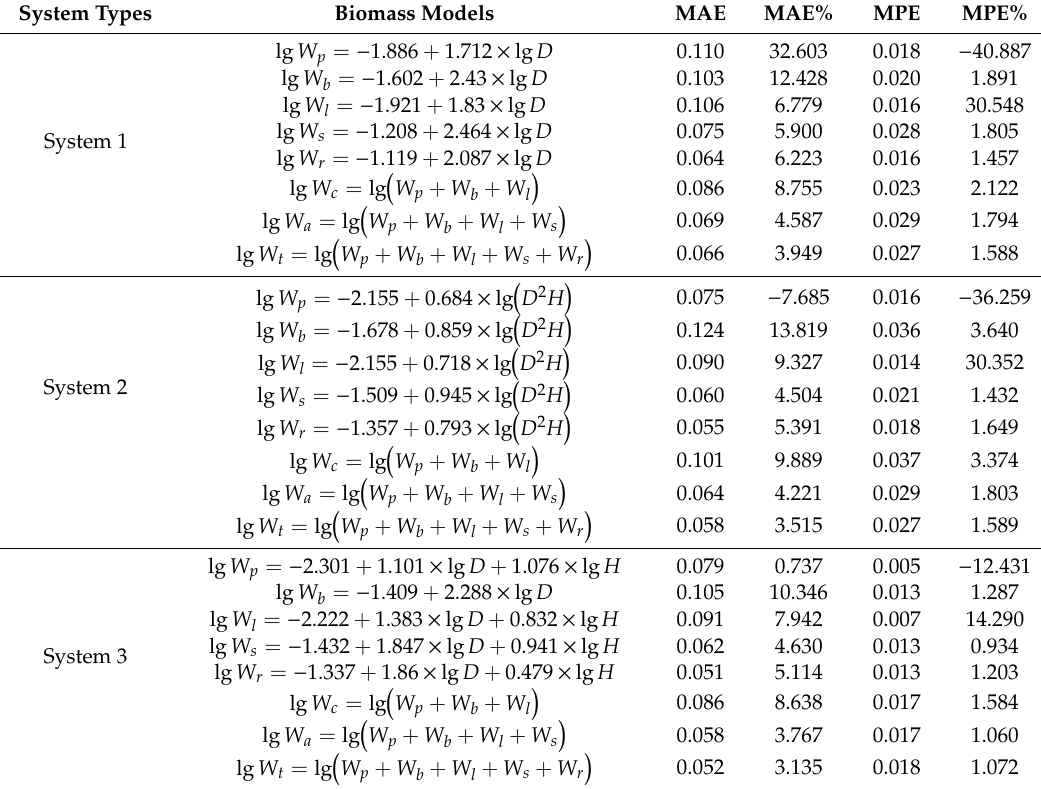
Table 4. Validation of log-transformed biomass equations using the jackknifing